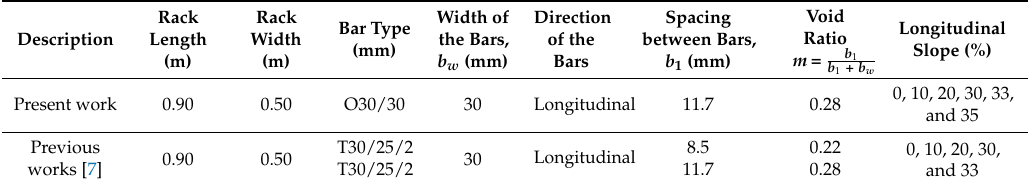
Table 3. Zingg’s shape classification.